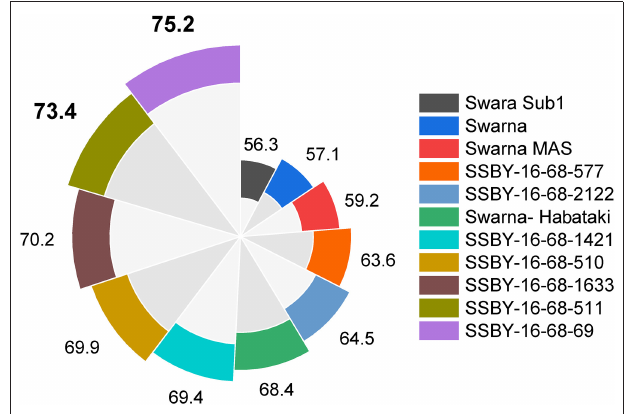
Frontiers in Plant Science |